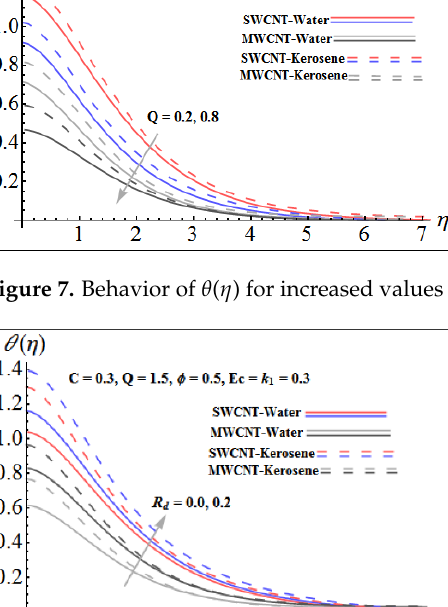
Figure 8. Behavior of θ ( η ) for increased values of 𝑅 (cid:3031) .